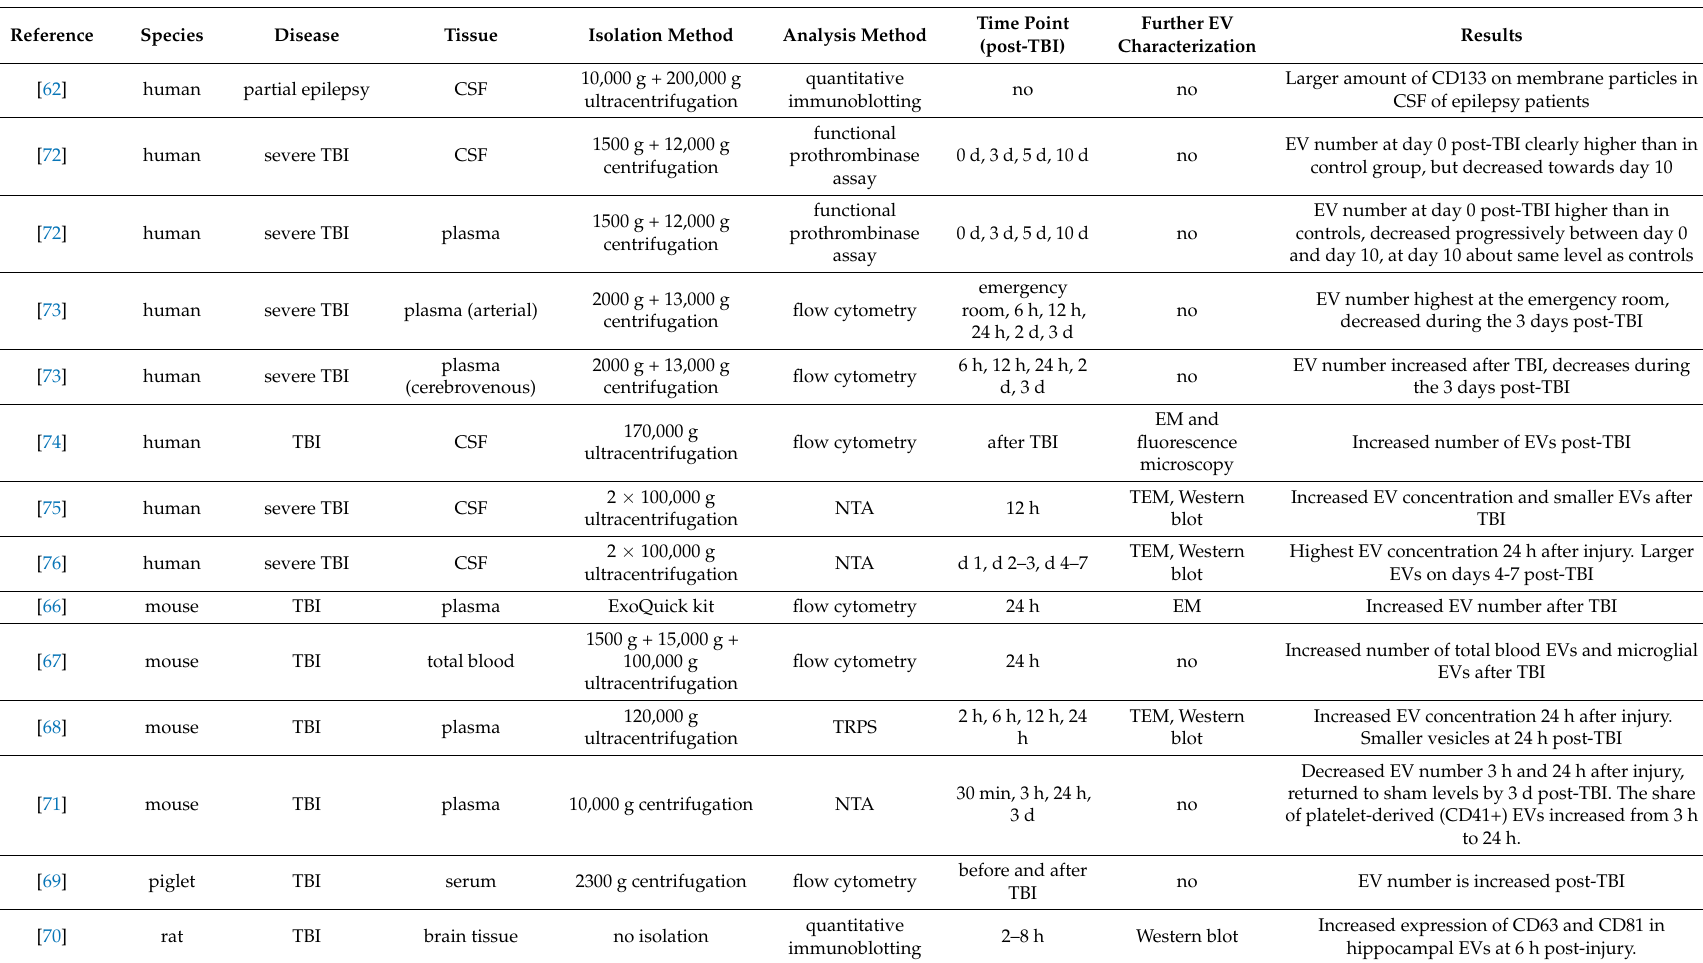
Table 1. Articles describing the changes in extracellular vesicle (EV) number in epilepsy and traumatic brain injury